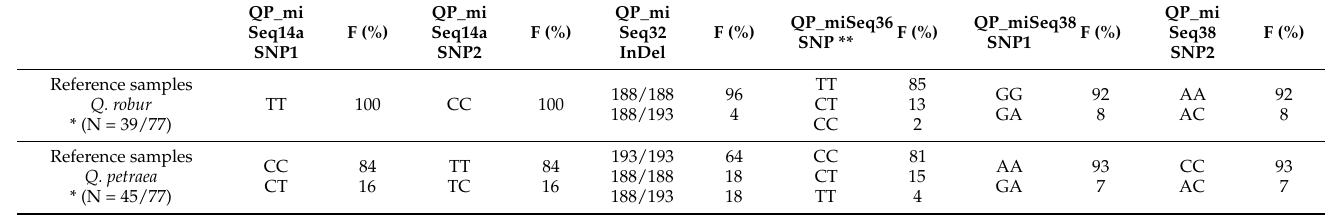
Table 3. Results from genotyping of a larger set of DNAs from the reference sample database (SDB) available at the Thuenen Institute of Forest Genetics using the genetic markers from Table 2 analysed and primer combinations from Table